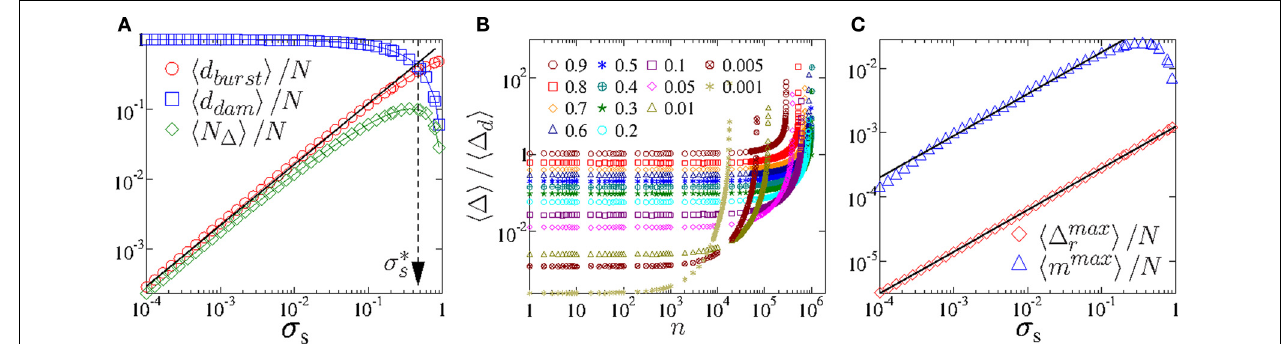
(cid:3) (cid:4) and of damage sequences (cid:5) (cid:2) d (cid:6) as a function of the order number n of d burst and due to bursts for several load values. (C) Average size of the largest record (cid:4) (cid:3) (cid:2) max and the average value of the largest waiting time (cid:3) breaking event (cid:4) r between consecutive records as function of load. All quantities are m max normalized by the number of fibers N in the bundle. The upper and lower straight lines have slope 0.625 and 0.65,